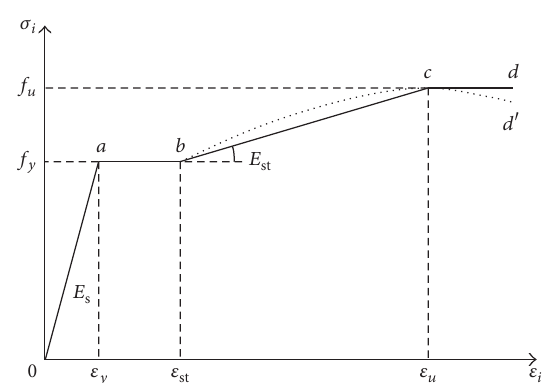
Figure 7: Constitutive relationship of equivalent stress-strain of steel tube.